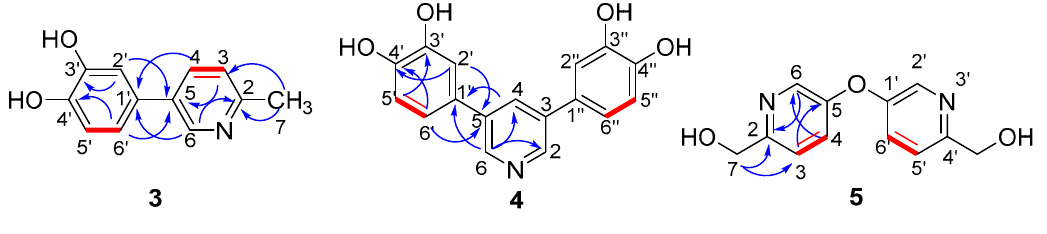
Figure 4. Key 1 H- 1 H COSY ( Figure 4. Key 1 H- 1 H COSY ( ) and HMBC ( ) correlations of compounds 3 – 5 . ) correlations of compounds 3 – 5 . Figure 4. Key 1 H- 1 H COSY ( ) and HMBC ( ) correlations of compounds 3 – 5 . Figure 4. Key 1 H- 1 H COSY ( ) and HMBC ( ) correlations of compounds 3 – 5 . Table 2. NMR spectral data of compounds 3 – 5 (CD 3 OD). Table 2. NMR spectral data of compounds 3 – 5 (CD 3 Table 2. NMR spectral data of compounds 3 – 5 (CD 3 OD). Table 2. NMR spectral data of compounds 3 – 5 (CD 3 OD).